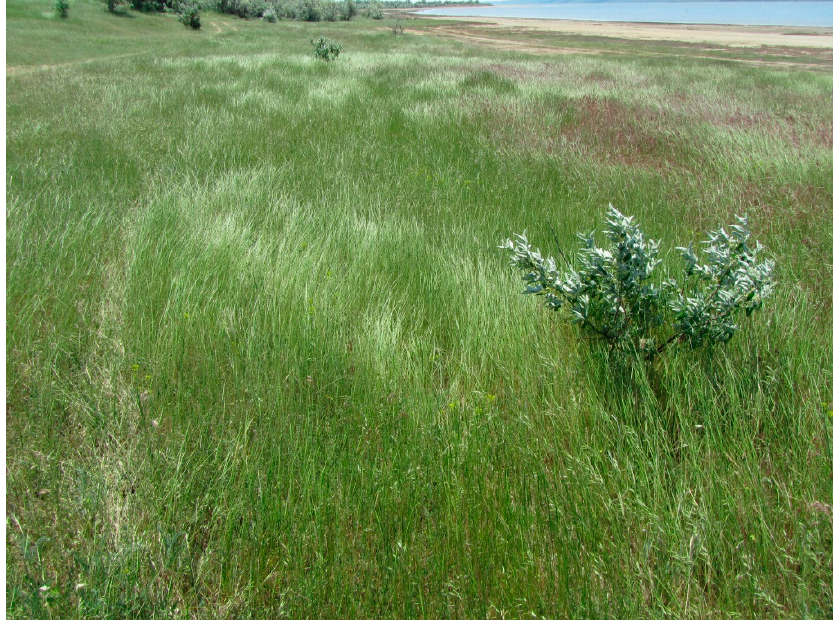
Figure 25. A fragment of the quasi-savanoid community of Aegilopsetum cylindricae association (surroundings of Kubanka village).